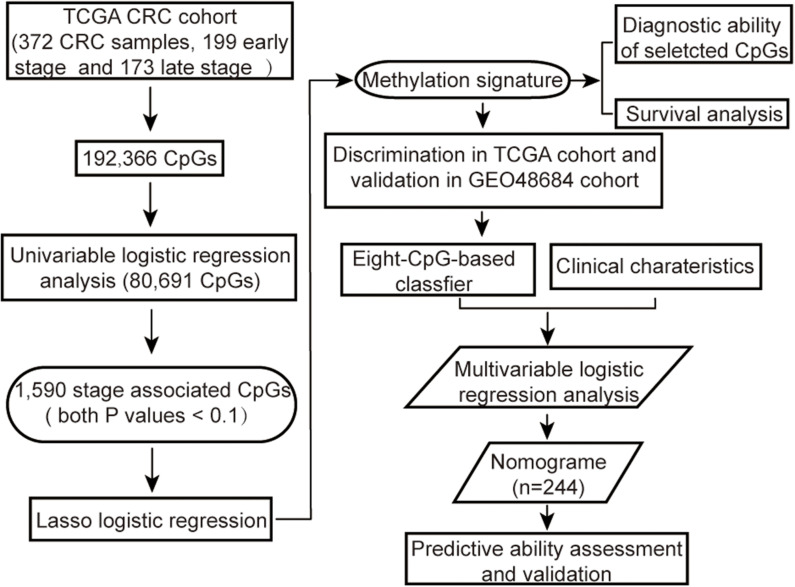
Flow chart showing the steps involved in systematical analysis.